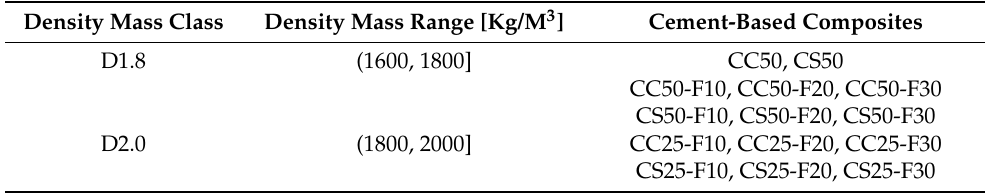
Table 3. Classification of cement-based composites developed in this research.